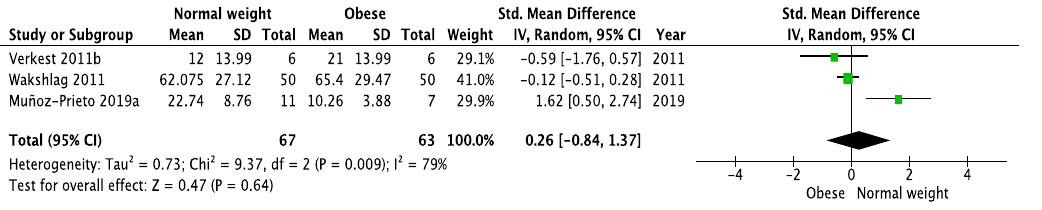
Figure 4. Meta-analysis of circulating HMW adiponectin concentrations in dogs after a weight loss program. SD: Standard deviation; Std: Standardized; IV: Interval variable; CI: Confidence interval.